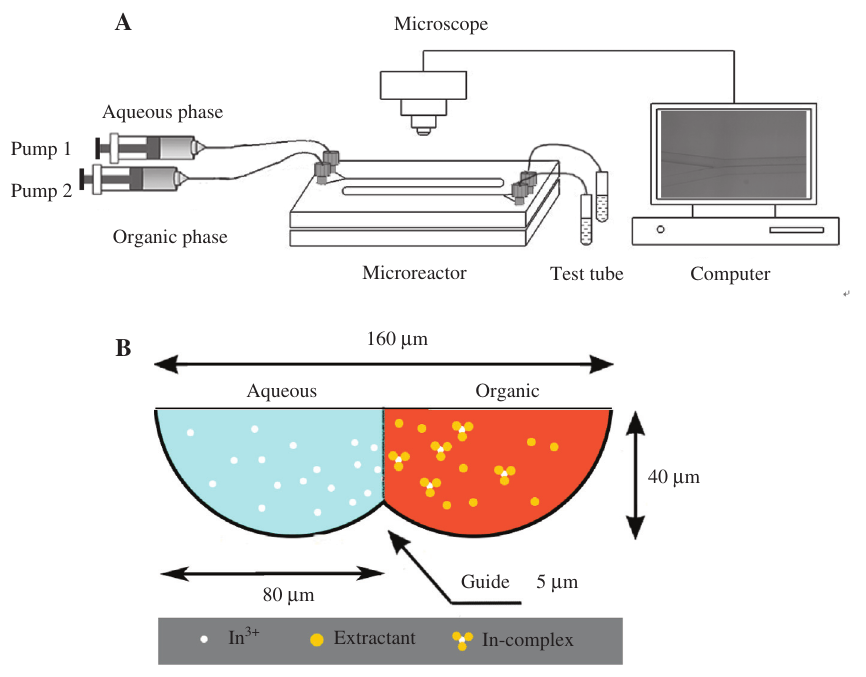
Figure 1 Schematic of microreactor system used in this study: (A) microreactor system; and (B) cross-section of the extraction